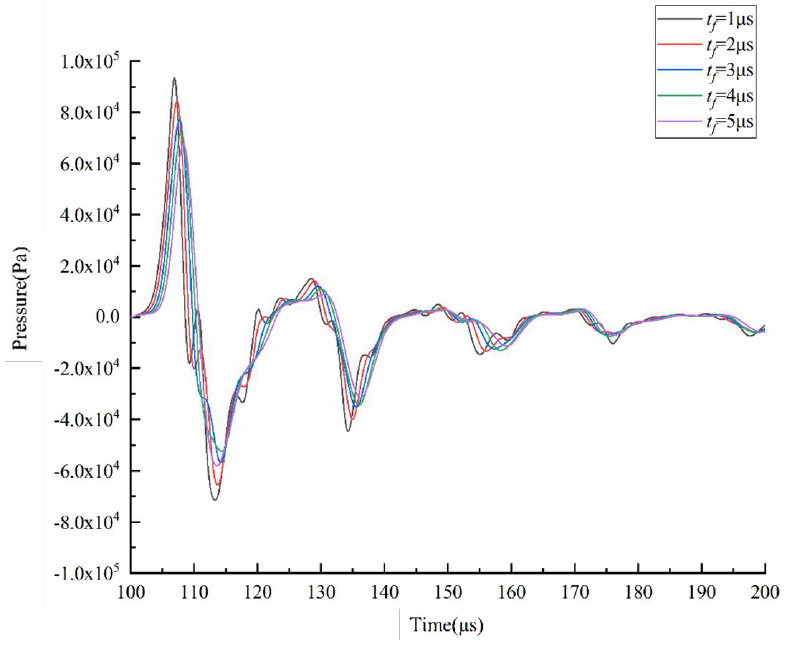
Figure 9. Effect of t f on the pressure at the nozzle.